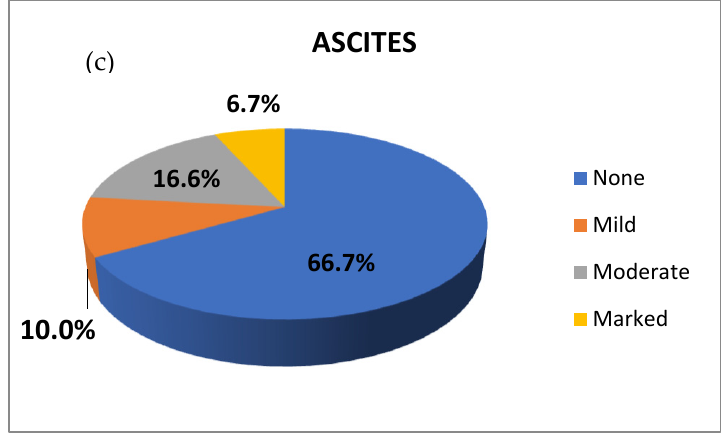
Figure 2. Clinical findings in HCC patients. ( a ) diabetes mellitus, ( b ) hypertension, and ( c ) percentage of HCC patients with ascites.